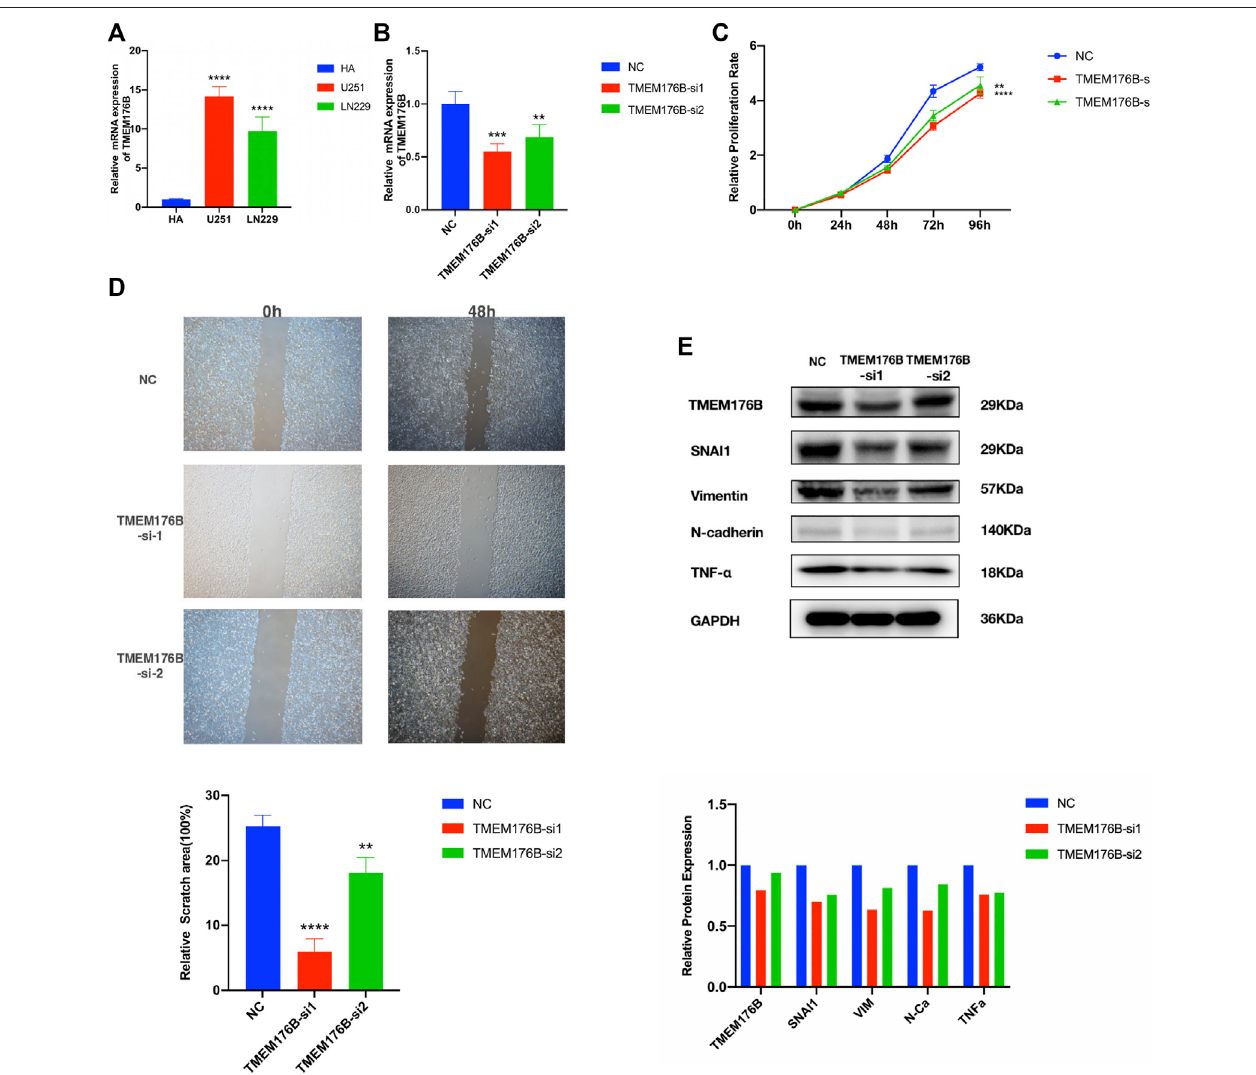
FIGURE 11 | Biological function investigation and in vitro veri fi cation of TMEM176B in glioma. (A) Relative mRNA expression levels of TMEM176B in the human astrocytes (HA) cell line and two glioma cell lines were detected by RT-qPCR. (B) Ef fi ciency of TMEM176B siRNAs was detected by RT-qPCR. (C) CCK-8 assay was performed to test the proliferation of LN229 cells. (D) Wound-healing assay was adopted to determine the migration of LN229 cells. Lower panel, bar graphs representing quanti fi cation of the scratch area. (E) Western blot analysis was adopted to detect the expression of related proteins of tumor progression. Lower panel, bar graphs representing quanti fi cation of Western blot bands. * p < 0.05; ** p < 0.01; *** p < 0.001; **** p < 0.0001.